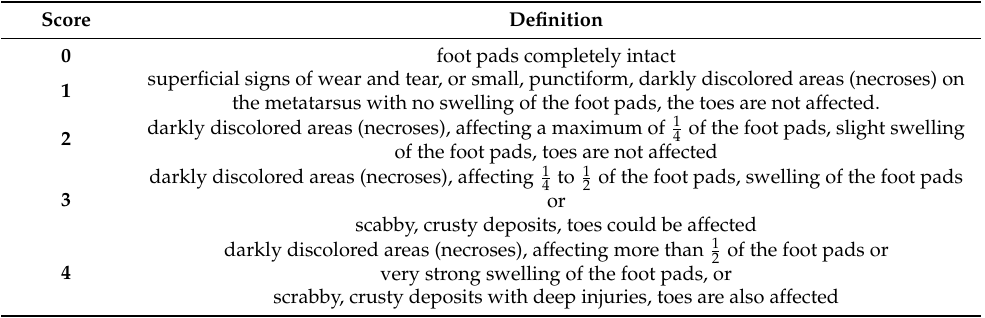
Table A7. Scoring of the foot pat health [27].